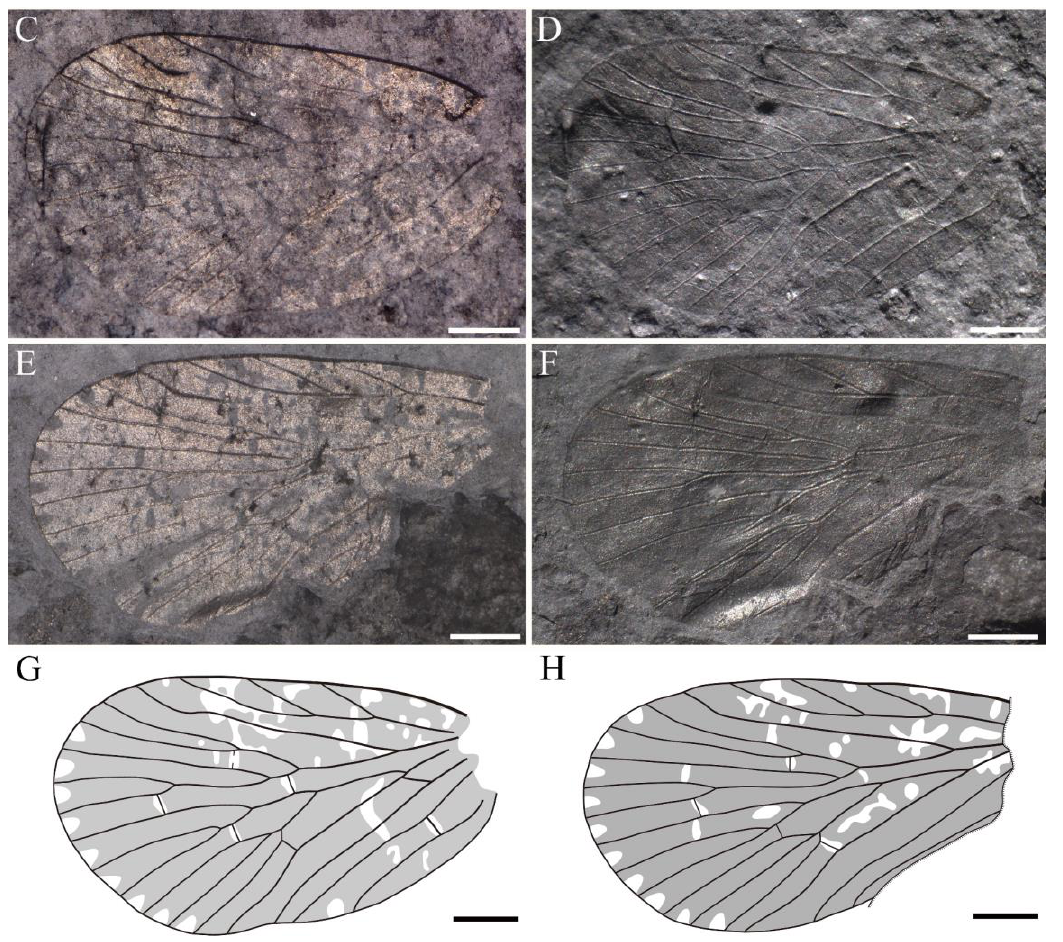
Figure 5. Sinoagetopanorpa rotunda sp. nov. ( A , B ) Photographs of NIGP200913 (holotype); ( C , D ) Photographs of NIGP200914 (paratype) (mirror image); ( E , F ) Photographs of NIGP200915 (paratype); ( G ) Line drawing of NIPG200914; ( H ) Line drawing of NIPG200915; ( A , C , E ) were taken when specimens were immersed under 70% alcohol in vertical reflected light; ( B , D , F ) were taken in oblique reflected light. Scale bars represent 1 mm in ( A – F ).